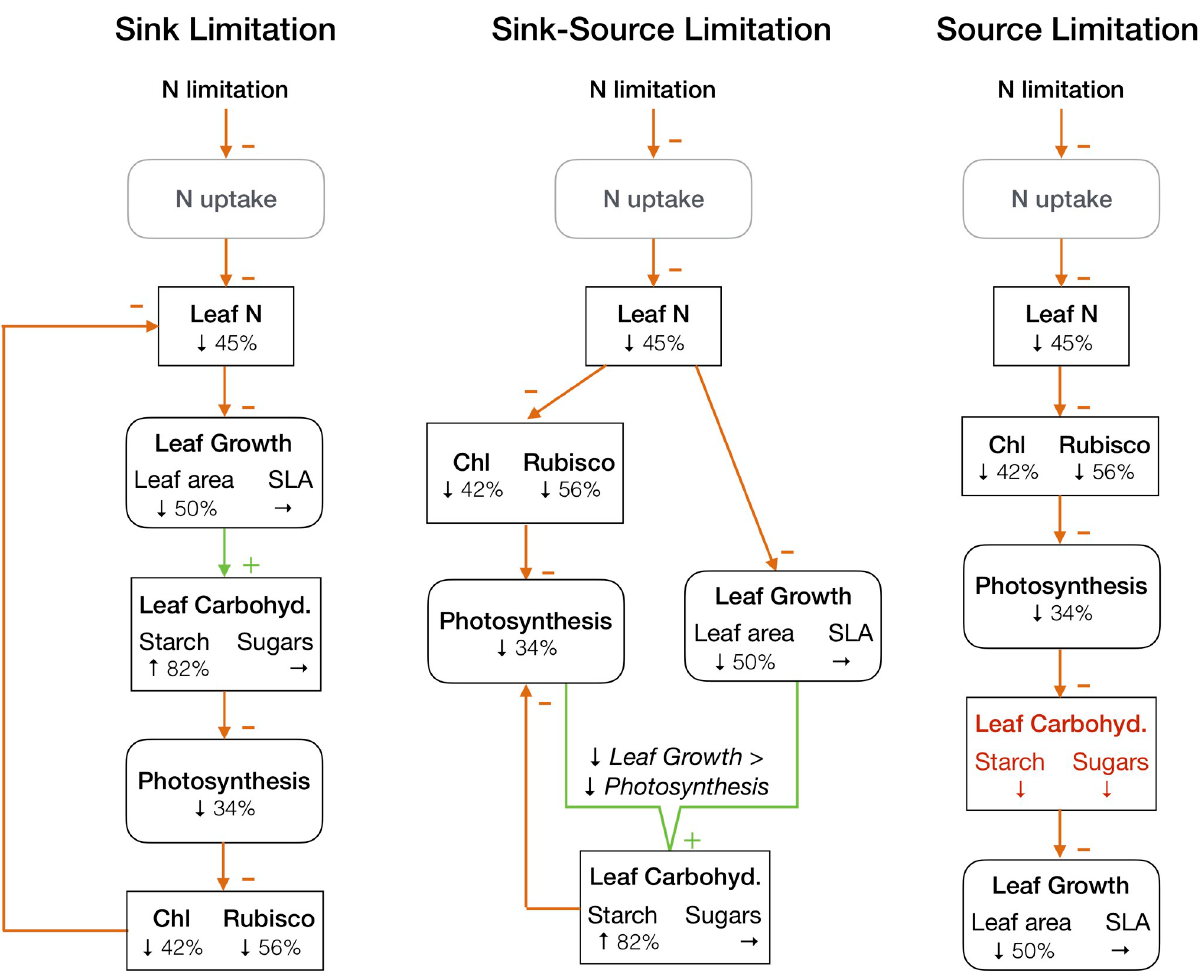
Fig 6. Potential relationships between photosynthesis and leaf growth of N-limited crops. In pure sink limitation (left panel), photosynthesis is limited by the use of carbohydrates in sink tissue. In pure source limitation (right panel), photosynthesis is limited by the availability of photosynthetic proteins. In combined sink and source limitation (middle panel), photosynthesis is limited by both the availability of photosynthetic proteins as well as the use of carbohydrates in sink tissue. Numbers and arrows show the results from this meta-analysis (at 100% N limitation). Square boxes show stocks, rounded boxes show processes. Arrows with a minus sign show negative impacts, arrows with a plus sign show positive impacts. Grey boxes indicate processes we did not examine in this meta-analysis. The pure source limitation (right panel) is not consistent with the results of our analysis, as under this mechanism we would expect a reduction in leaf